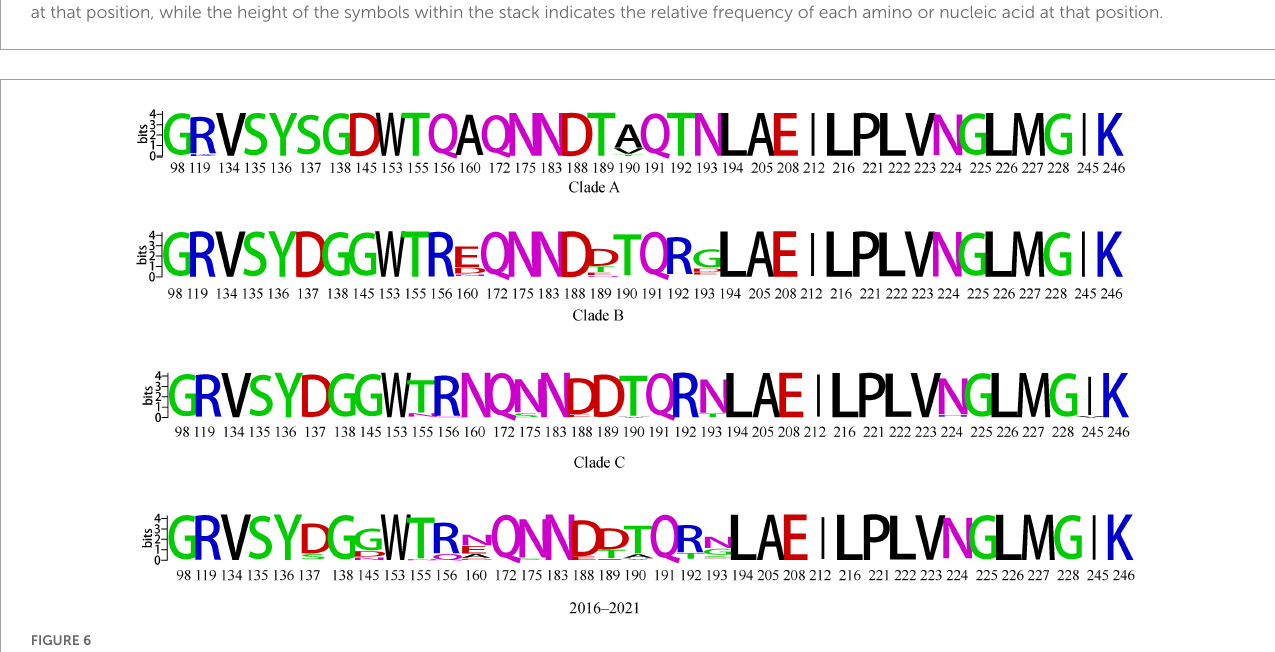
FIGURE6 Conserved amino acid analysis of key receptor-binding sites of clades A, B and C and 2016–2021 HA genes of H9N2 viruses. Each logo consists of stacks of symbols, one stack for each position in the sequence. The overall height of the stack indicates the sequence conservation at that position, while the height of symbols within the stack indicates the relative frequency of each amino or nucleic acid at that